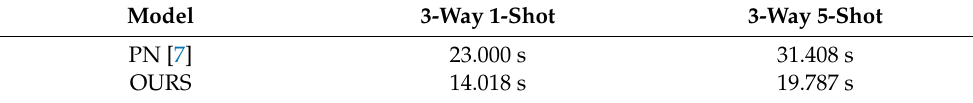
Table 6. The time usage of the methods to preprocess 1000 recognition tasks in the test stage.